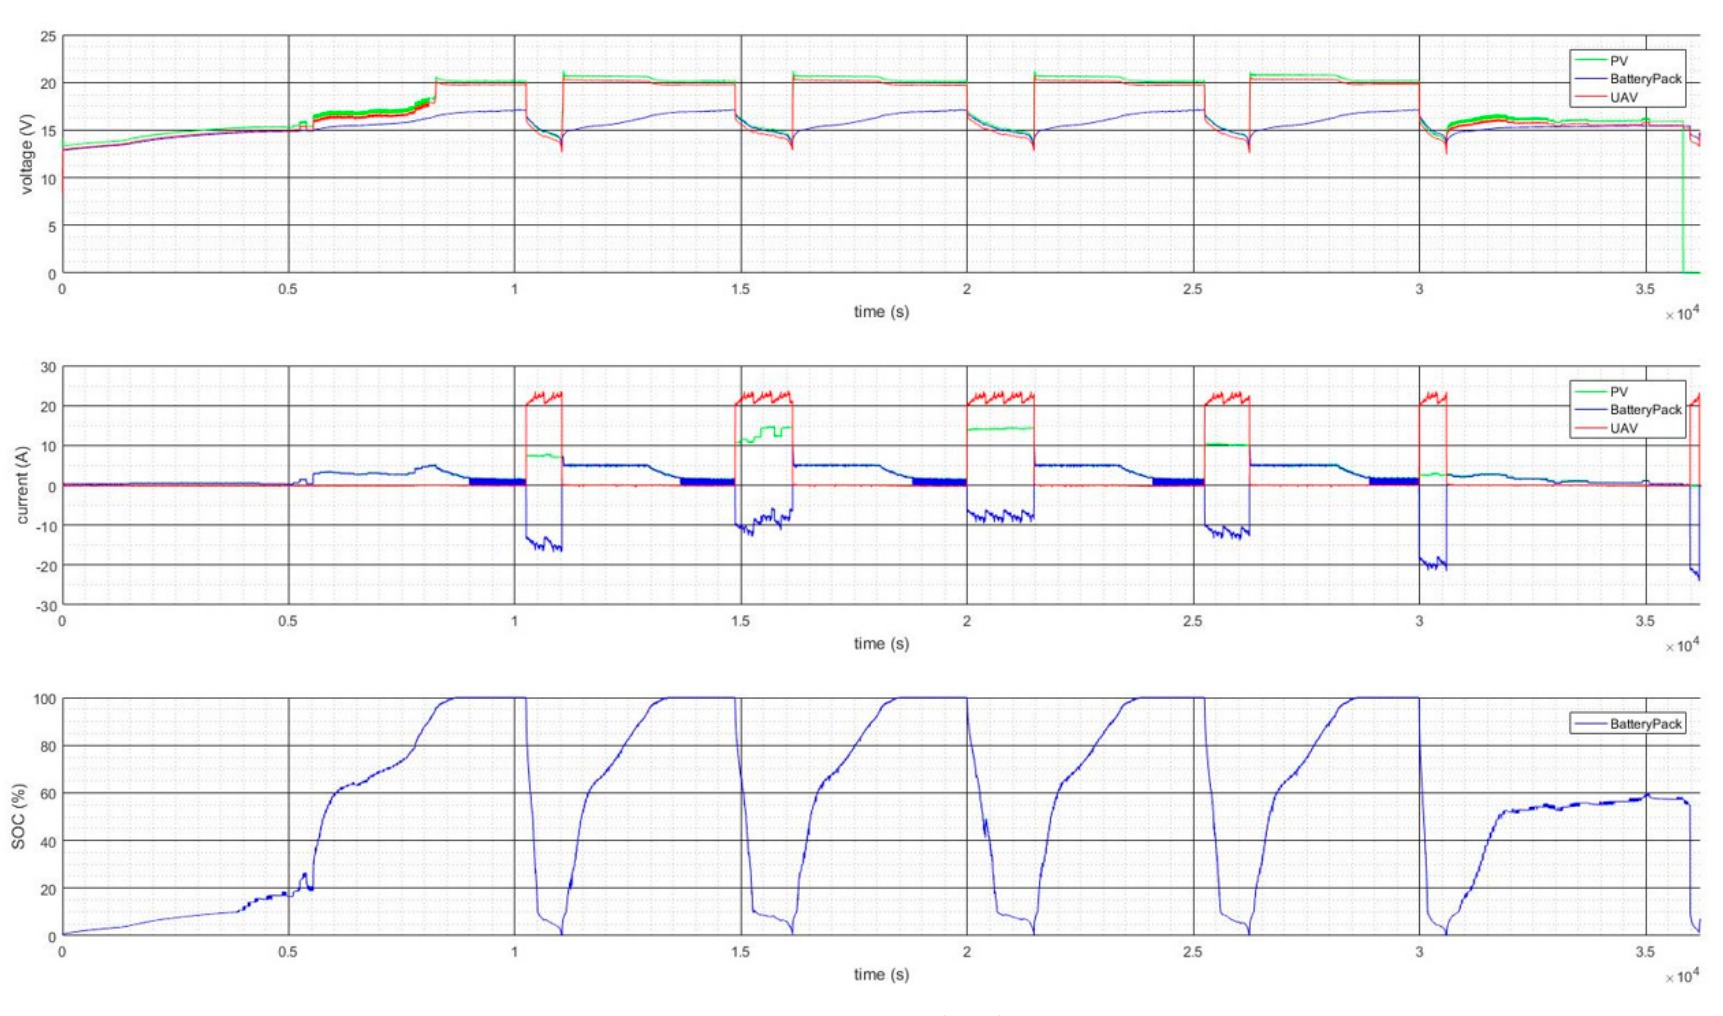
Figure 13. Experimental result.